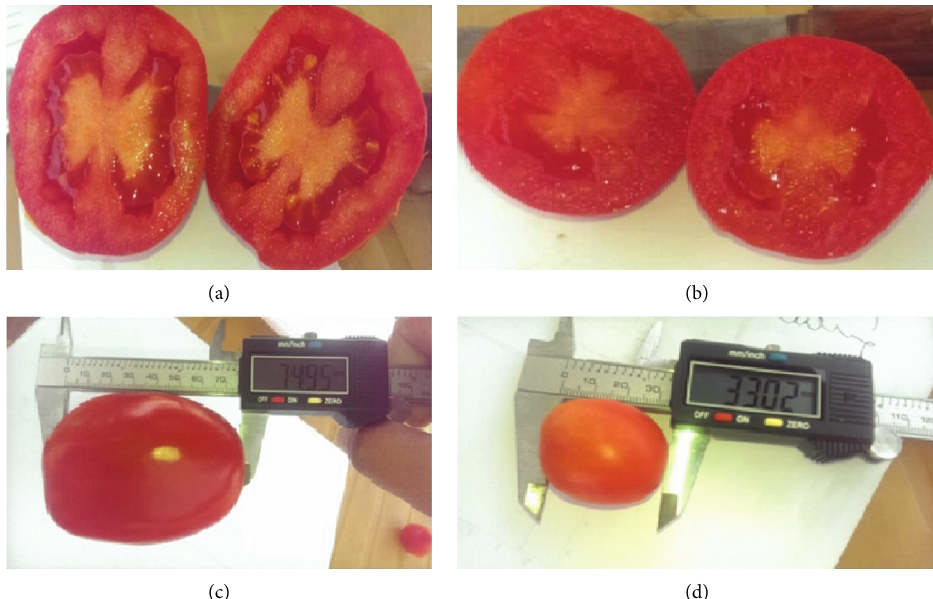
Figure 1: Normal seeded and parthenocarpic tomatoes. (a) Cross section of normal seeded tomato. (b) Cross section of parthenocarpic tomato. (c) Length of normal seeded tomato. (d) Length of parthenocarpic